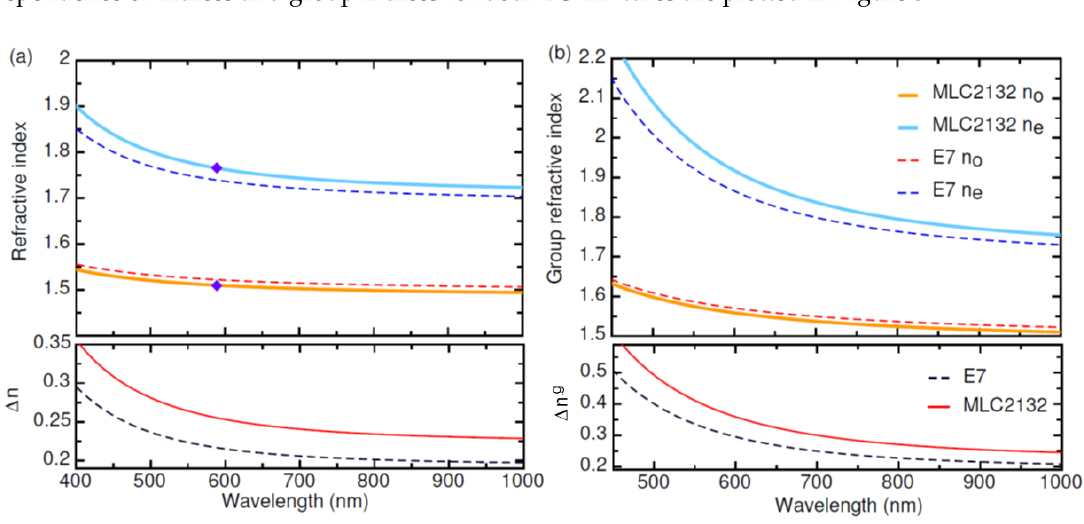
Figure 3. Chromatic variation of the refractive index and ∆ n in ( a ) and chromatic variation of the group refractive index and ∆ n g in ( b ). The legend stands for ( a ) and ( b ) : E 7 (dotted lines) and MLC 2132 (solid lines). Purple dots in ( a ) are the data provided by the furnisher (20 ◦